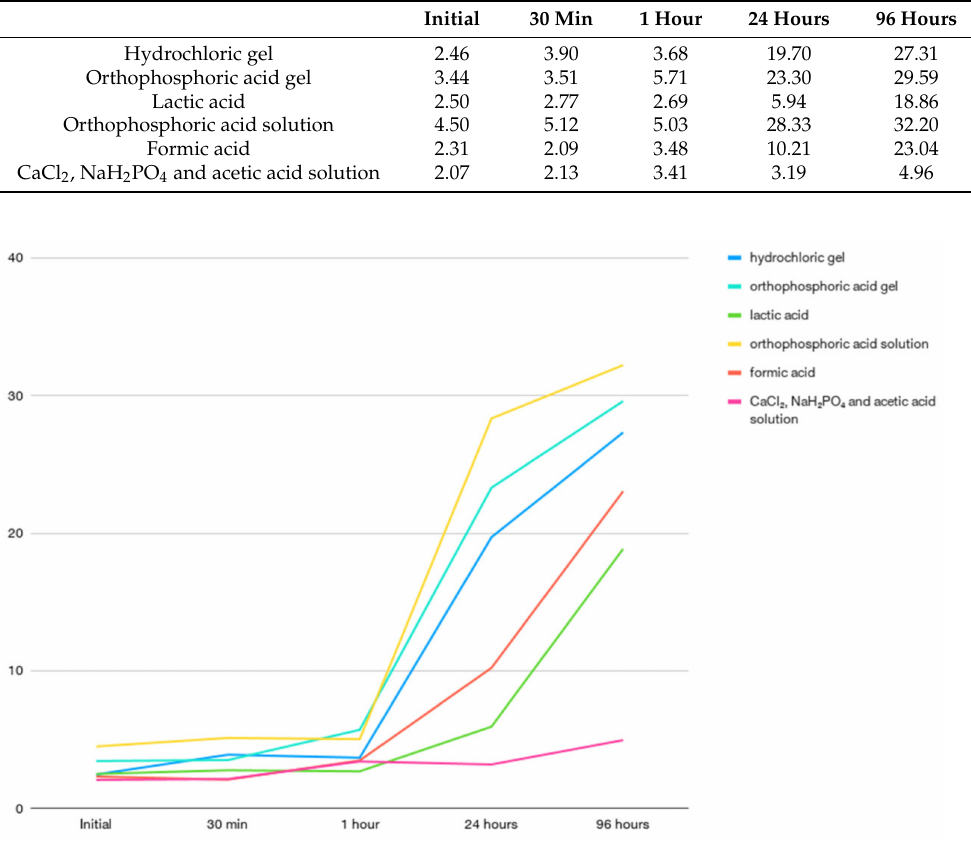
Figure 9. The mean values measured with the DIAGNODent™